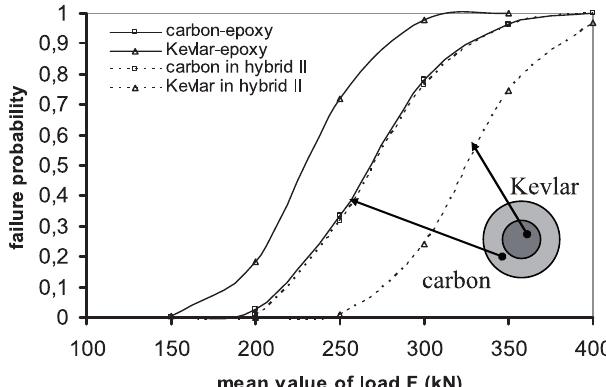
Fig. 14. Failure probability of hybrid II according to axial load F ( q = 0 . 5